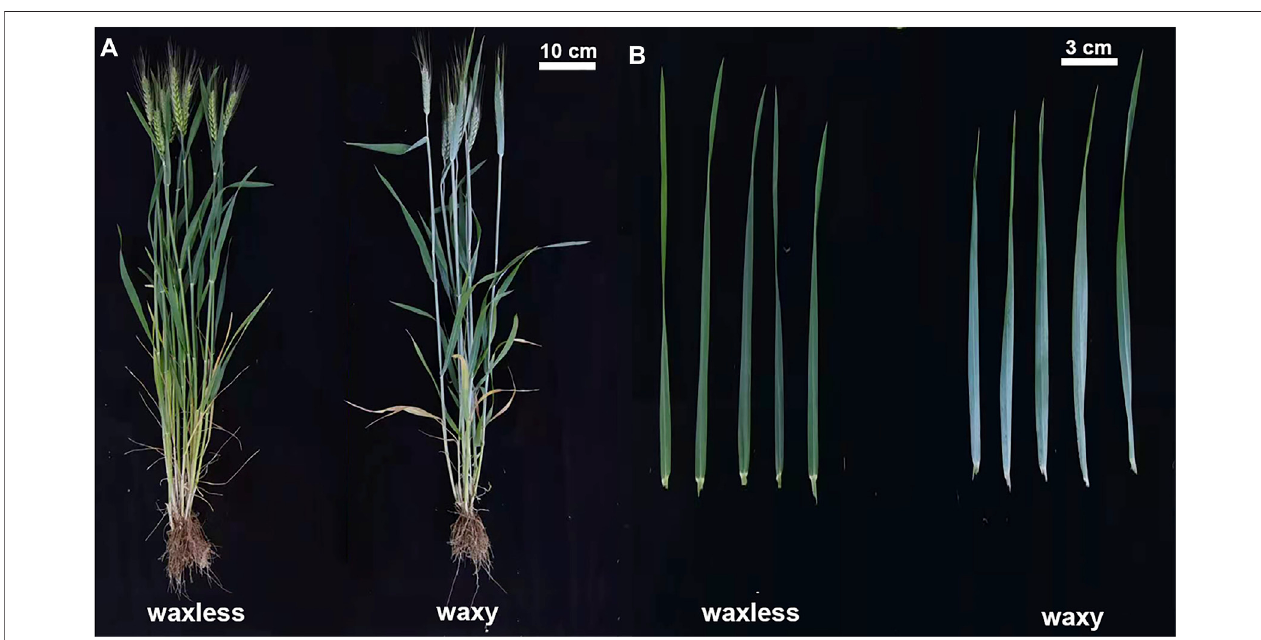
FIGURE 1 | Phenotype of low-wax mutant waxless and multi-wax mutant waxy . (A) The whole plant phenotype of waxless and waxy . (B) Leaf phenotype of waxless and waxy .